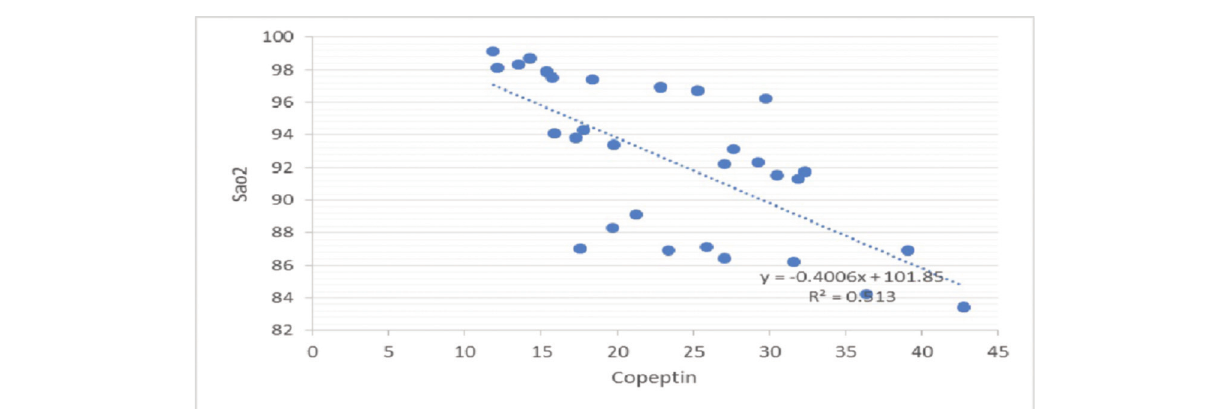
Correlation between copeptin and SaO 2 . SaO 2 , oxygen saturation.